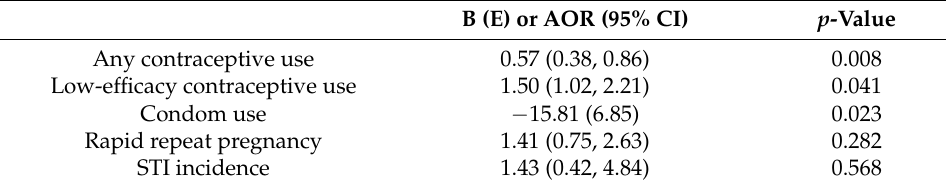
Table 2. Associations between ACEs exposure and sexual